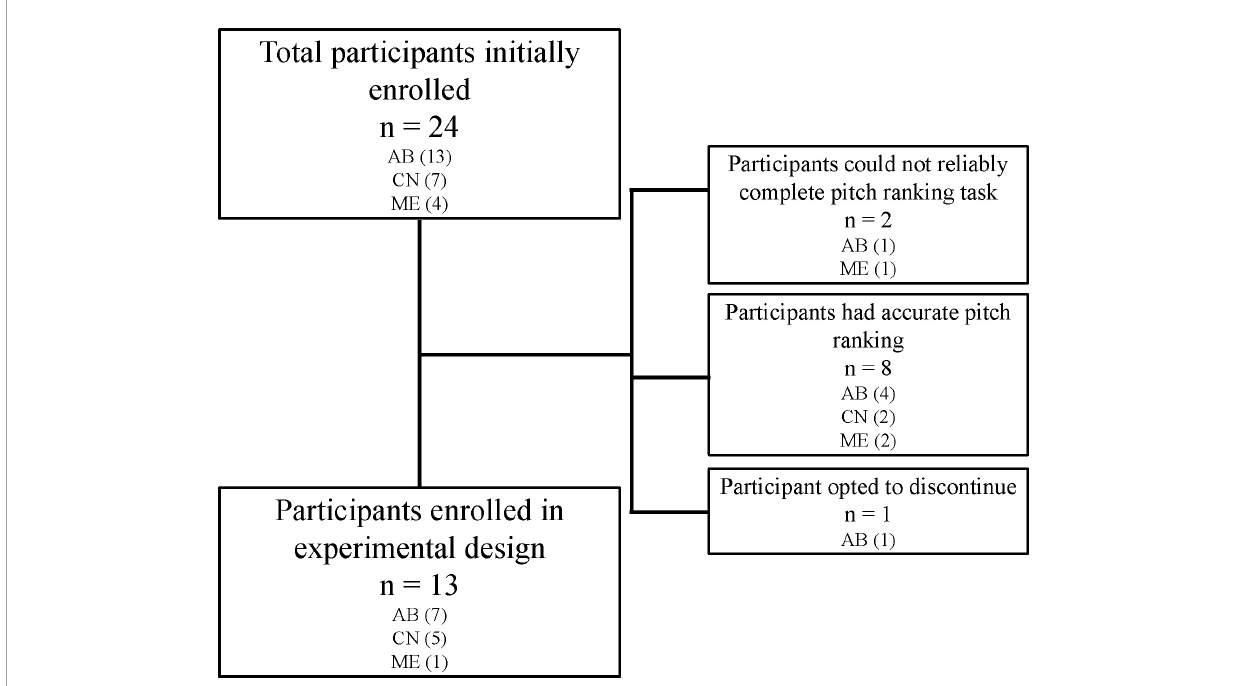
FIGURE1 While 24 participants were initially enrolled in the study, only 13 participants completed the experimental study. Two participants could not reliably complete the pitch ranking task and therefore did not have electrodes deactivated. Eight participants reported pitch ranking which matched tonotopic organization of the cochlea and therefore had no indiscriminate pairs to consider for deactivation. One participant discontinued for reasons unrelated to the study